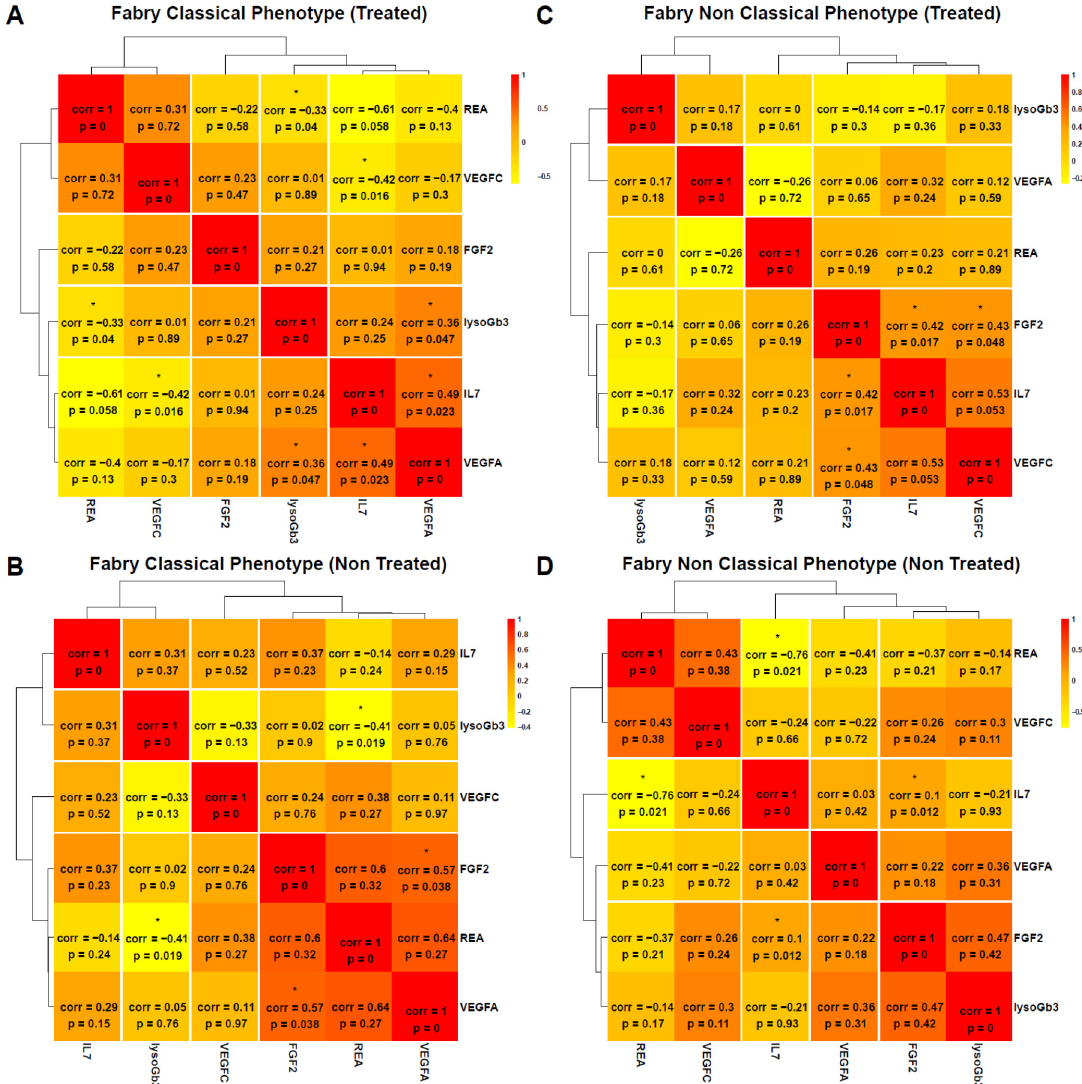
Figure 4. Correlation between LysoGb3, residual enzyme activity (REA), FGF2, IL-7, VEGFA, and VEGF across different Fabry subgroups related to treatment status and phenotype. ( A ) Correlated matrix for treated Fabry samples with classical phenotype. Significant correlations: REA vs. lysoGb3 (Corr = − 0.33, p = 0.04); IL-7 vs. VEGFC (Corr = − 0.42, p = 0.01); VEGFA vs. lysoGb3 (Corr = 0.36, p = 0.04); IL-7 vs. VEGFA (Corr = 0.49, p = 0.2). ( B ) Correlated matrix for non-treated Fabry samples with classical phenotype. Significant correlations: REA vs. lysoGb3 (Corr = − 0.41, p = 0.01); FGF2 vs. VEGFA (Corr = 0.57, p = 0.03). ( C ) Correlated matrix for treated Fabry samples with non-classical phenotype. Significant correlations: FGF2 vs. VEGFC (Corr = 0.43, p = 0.04); FGF2 vs. IL-7 (Corr = 0.42, p = 0.01). ( D ) Correlated matrix for non-treated Fabry samples with non-classical phenotype. Significant correlations: IL-7 vs. REA (Corr = − 0.76, p = 0.02); FGF2 vs. IL-7 (Corr = 0.1, p = 0.01). Corr = Spearman correlation, * = significant. FGF2; fibroblast growth factor 2, IL7; interleukin 7, VEGFA; vascular endothelial growth factor A, VEGFC; vascular endothelial growth factor C, REA; residual enzymatic activity, lysoGb3; globotriaosylsphingosine.